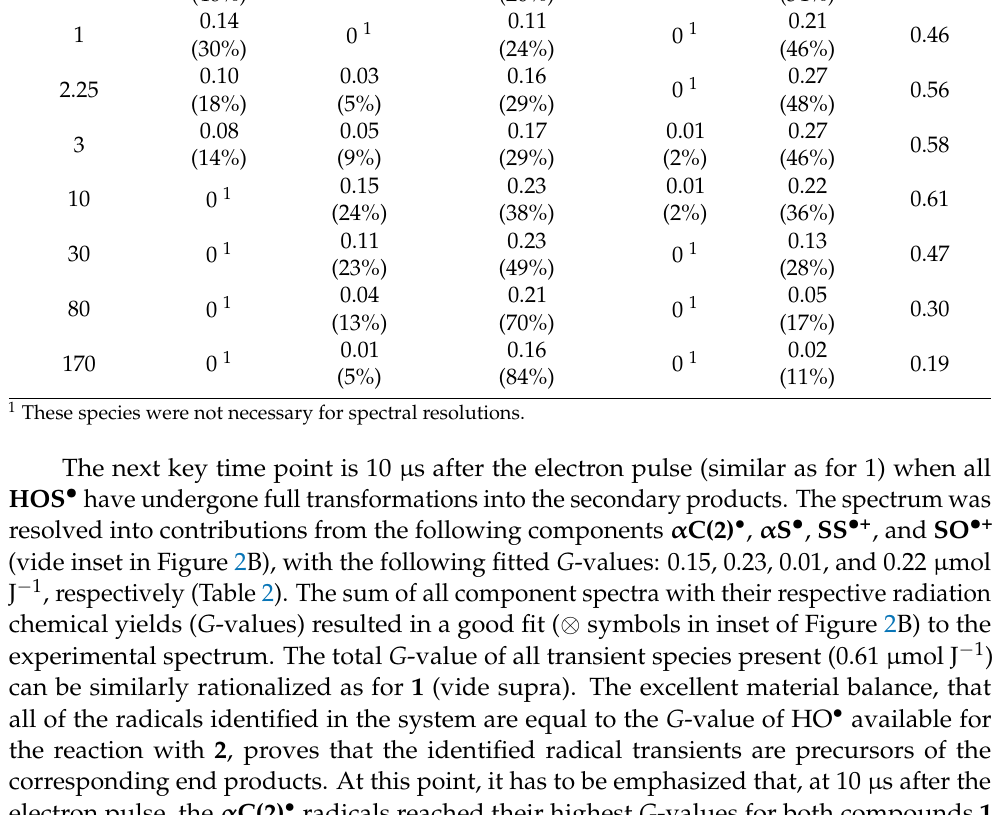
Table 2. The radiation chemical yields ( G , µ mol J − 1 ) of radicals and their percentage contribution (in parenthesis) to the total yield of radicals present in the reaction of HO • with cysteine-methylated derivative 2 at different times after the electron pulse at pH 7. Time ( µ s)